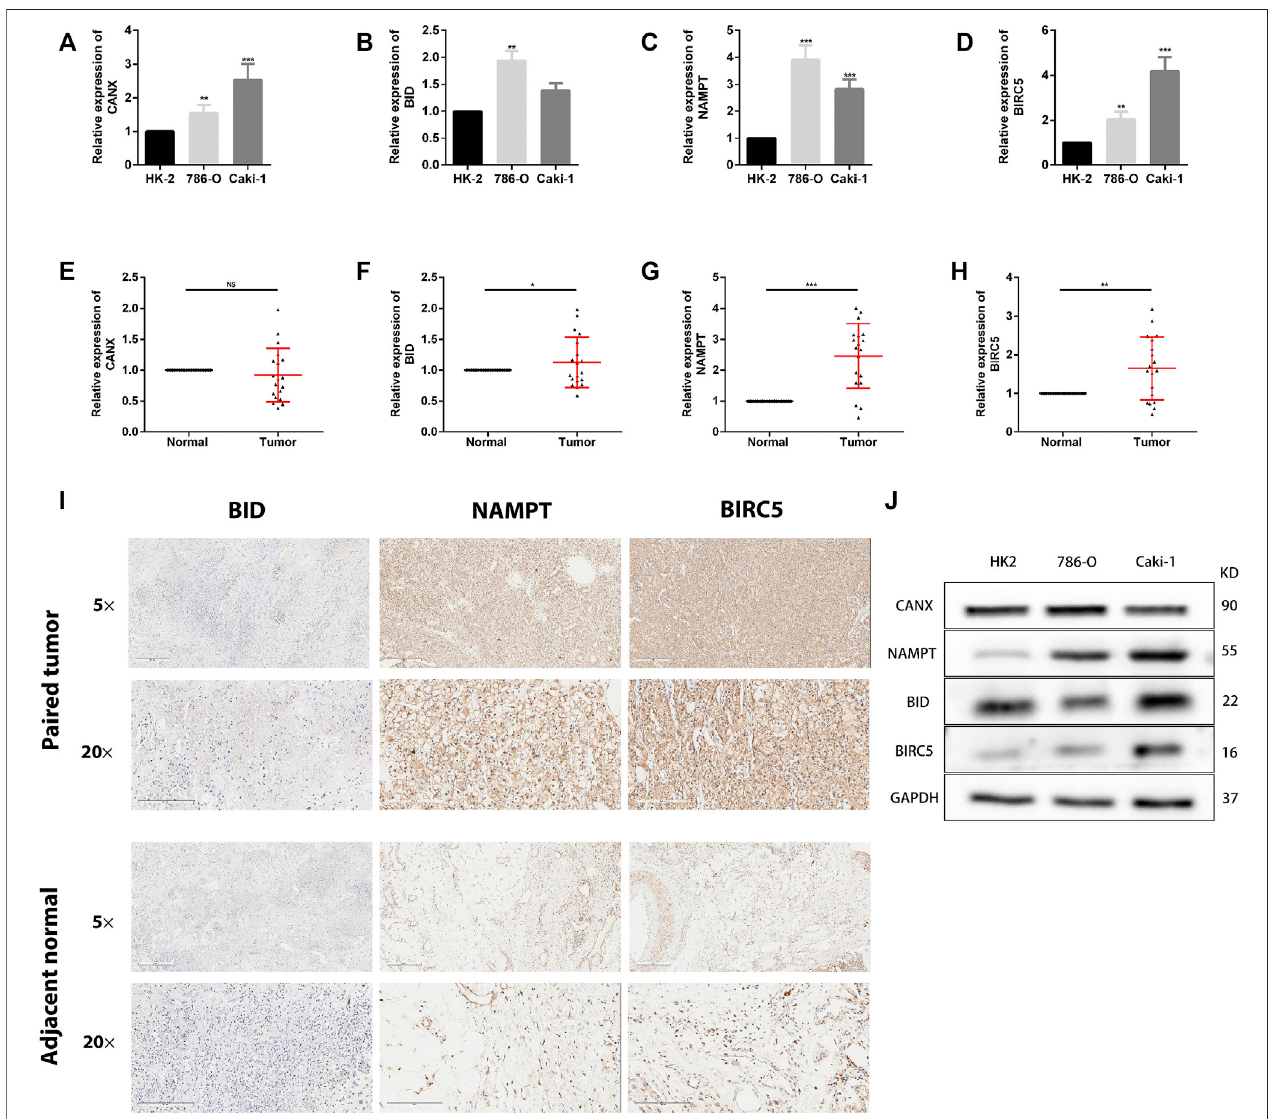
FIGURE12| Theexpression ofthese genesin humankidneyrenal clear cellcarcinoma(KIRC) specimens, adjacentnormal tissues,and cell lines. (A – D) qRT-PCR analysis of CANX (A) , BID (B) , NAMPT (C) , and BIRC5 (D) in KIRC cell lines. GAPDH was used as a loading control. (E – H) qRT-PCR analysis of CANX (E) , BID (F) , NAMPT (G) , and BIRC5 (H) in paired KIRC tissues ( n (cid:1) 19). (I) Representative images of BID, NAMPT, and BIRC5 protein immunochemistry in KIRC tissues compared with adjacent normal kidney tissues. Magni fi cation, × 5 and × 20. (J) Western blotting analysis of related differentially expressed genes (DEGs) expression levels in normal kidney cell line (HK-2 cells) and two KIRC cell lines (786-O and caki-1). * p < 0.05, ** p < 0.01, and *** p < 0.001.